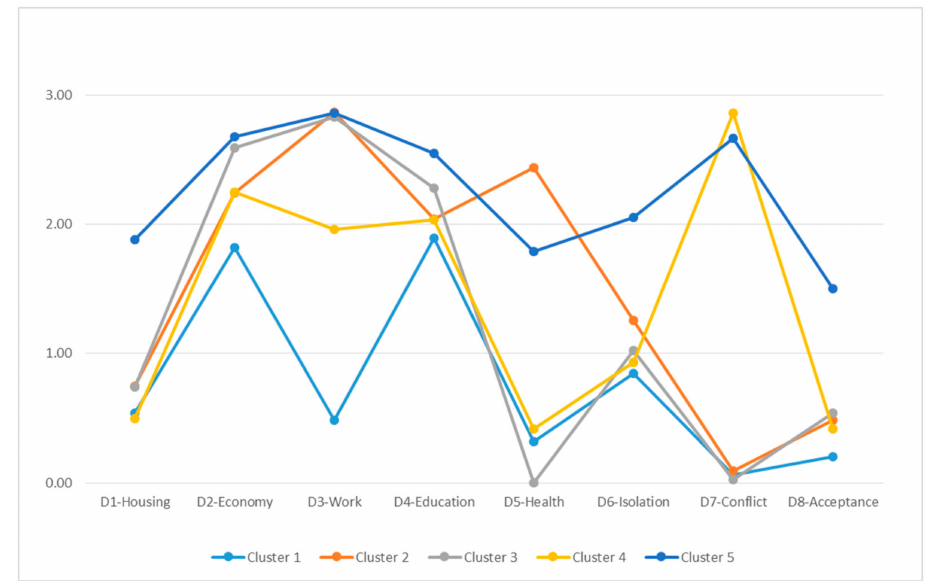
Figure 3. Scope and intensity of social exclusion by centers for the final clusters (five